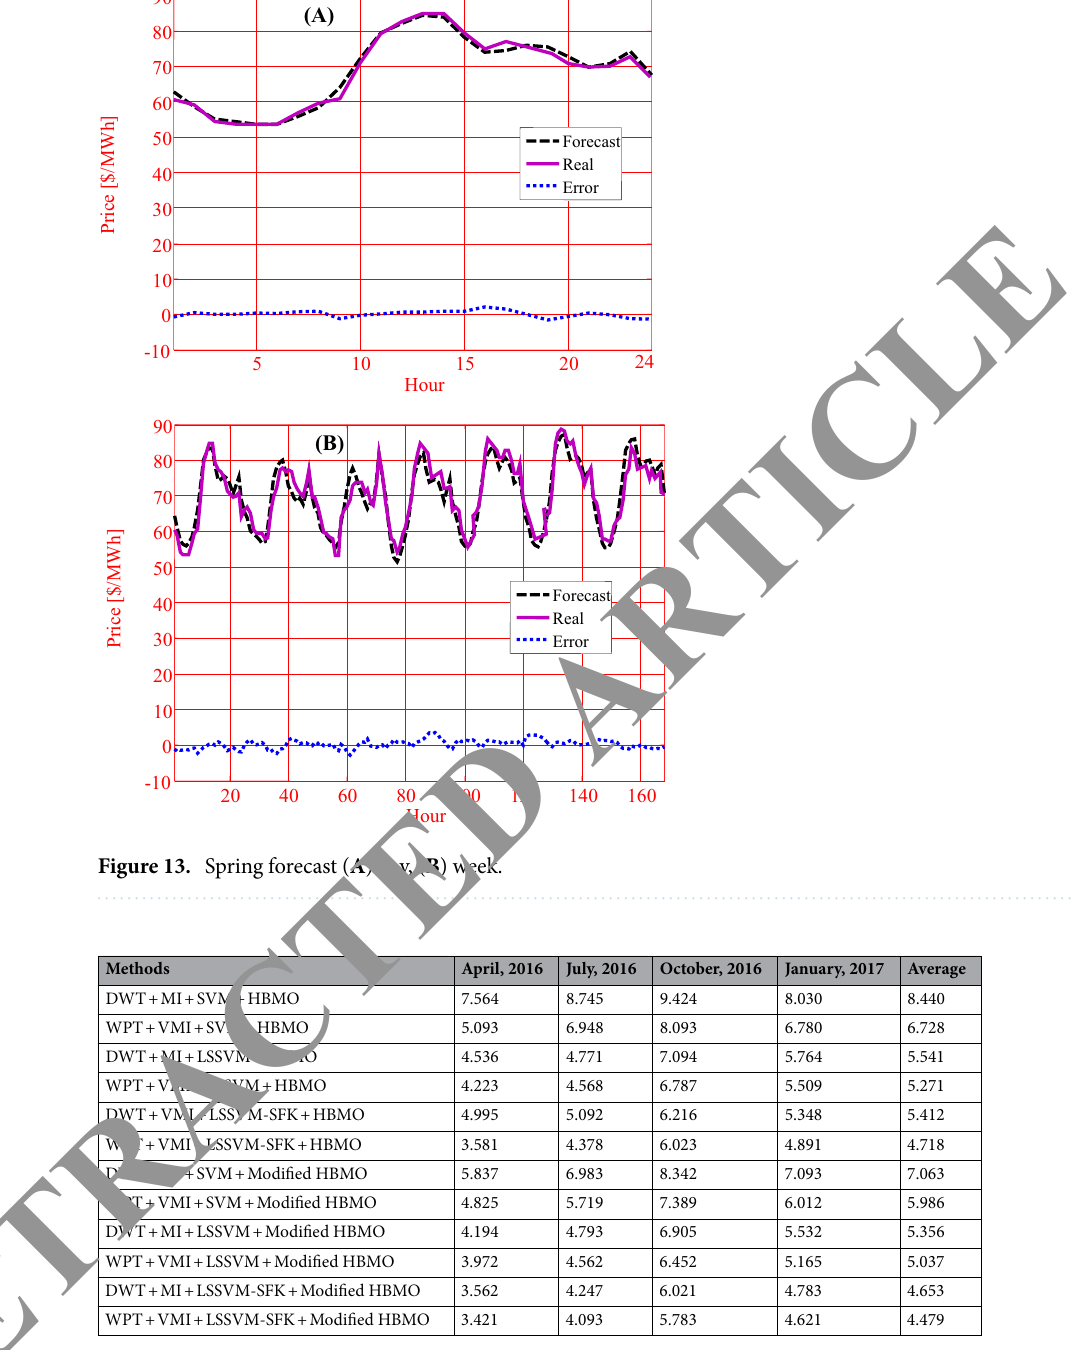
Table 4. MAPE for forecasting error of